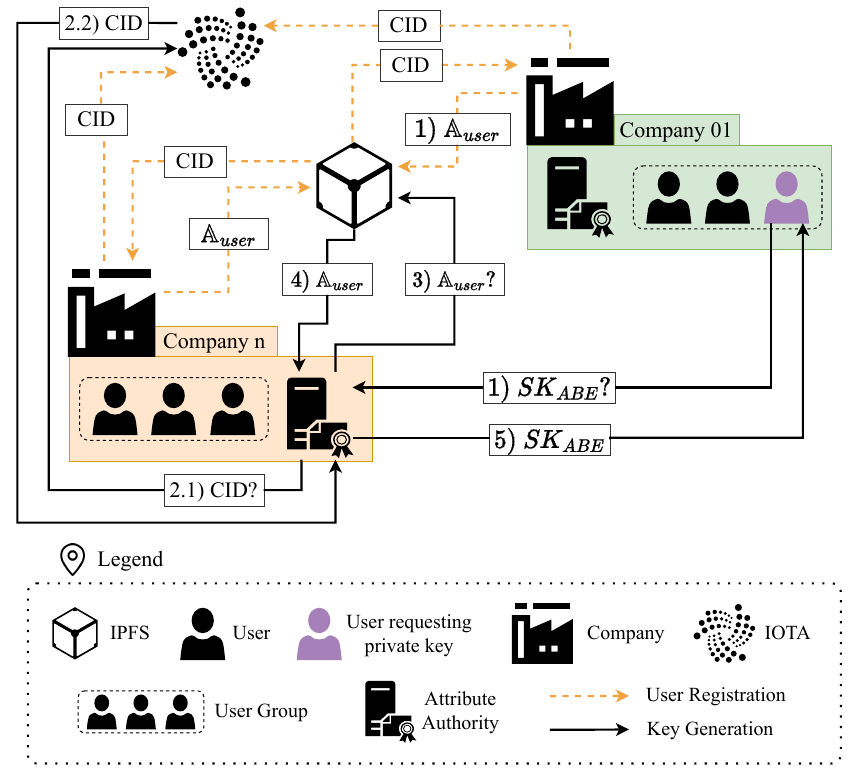
Figure 3. CP-ABE attribute validation with IPFS and